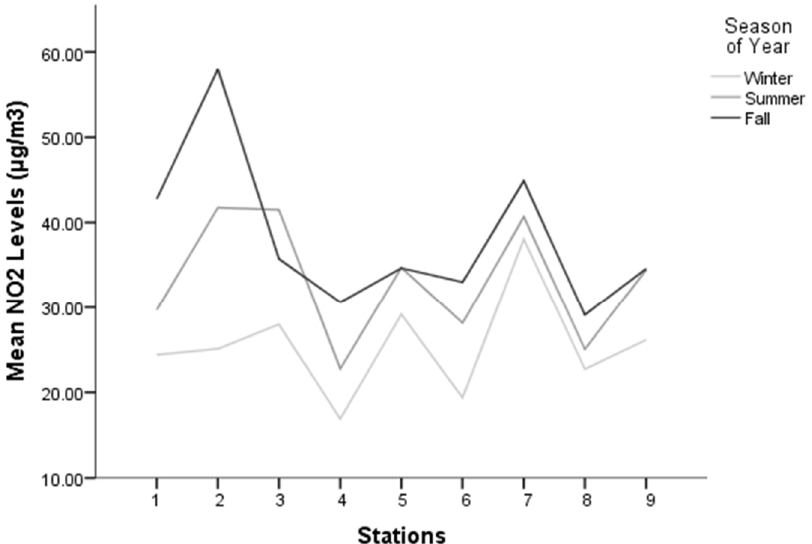
Table 4. Comparison of O 3 Variation by Season and Traffic Density. Figure 3. Nitrogen dioxide levels in winter, fall, and summer at Jamaica Center in 2019. Key: (1) ABC